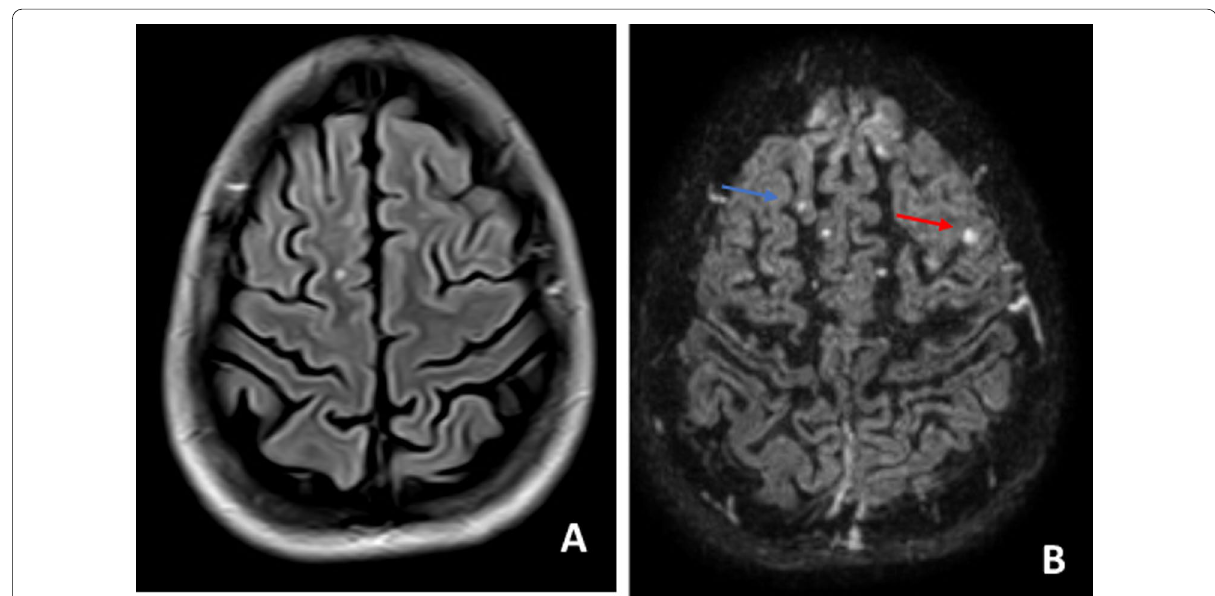
Fig. 1 A 28-year-old female patient with secondary progressive MS and EDSS score of 3. A Axial FLAIR and B axial DIR at the same level revealed multiple cortical and subcortical plaques, the axial DIR revealed cortical plaque-type 1 (red arrow) and type 2 (blue arrow) which was not identified in the FALIR sequence